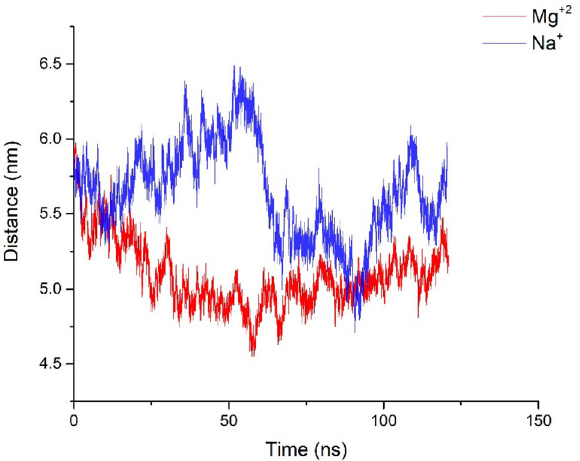
Figure 2. The distance between the center of mass bilayer and siRNA in the absence and presence of Mg 2+